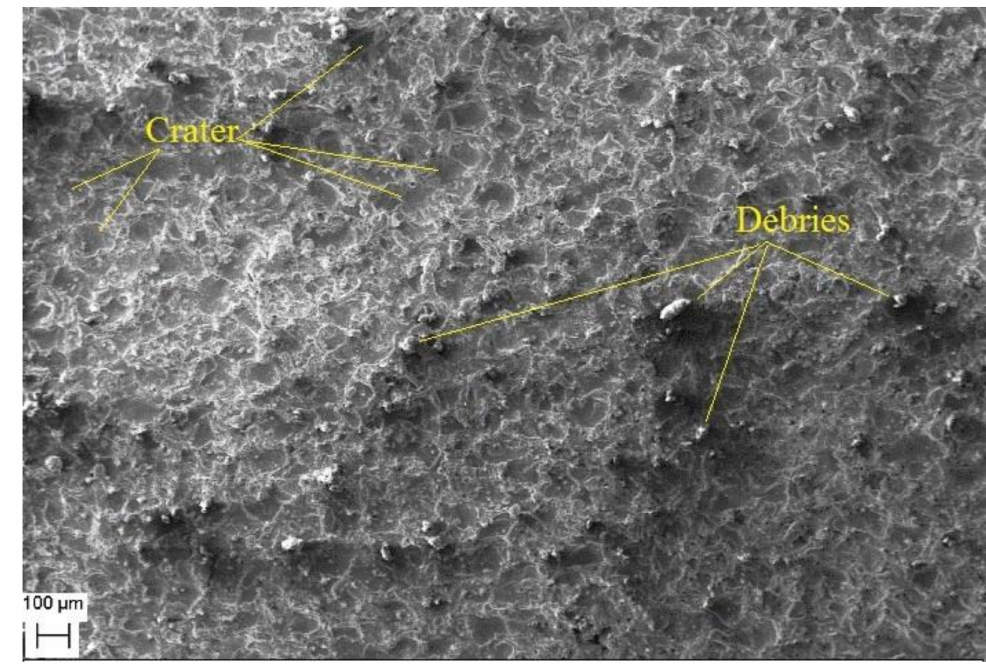
Figure 7. The cut